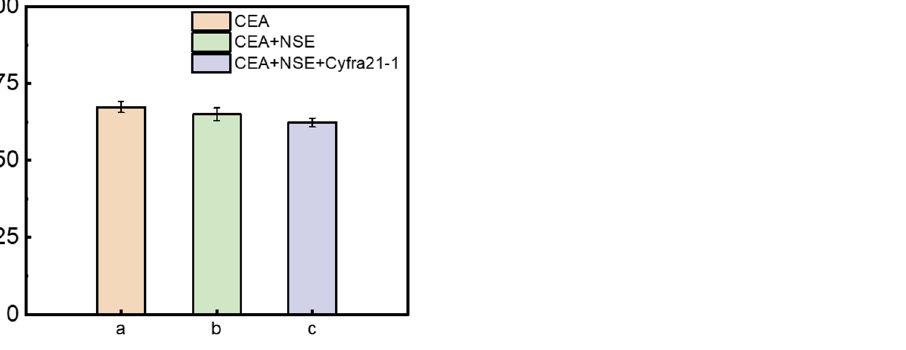
Figure 7. Selectivity verification in the presence of interfering protein by differential pulse voltammetry (DPV) method.